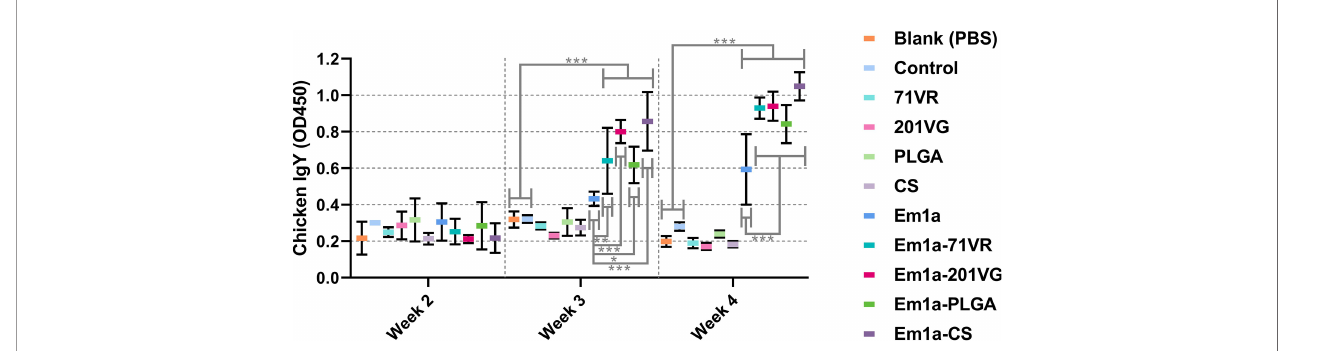
FIGURE 6 | Determination of Em1a-speci fi c antibody in the animals ’ sera. Each sample was tested once, and values were estimated using one-way ANOVA followed by Dunnett ’ s test. Comparisons among Em1a, Em1a-71VR, Em1a-201VG, Em1a-PLGA, and Em1a-CS group were conducted by ANOVA following Bonferroni ’ s correction. Values were presented as the mean ± SD (n = 5). In all studies, * p < 0.05, ** p < 0.01, and *** p < 0.001.